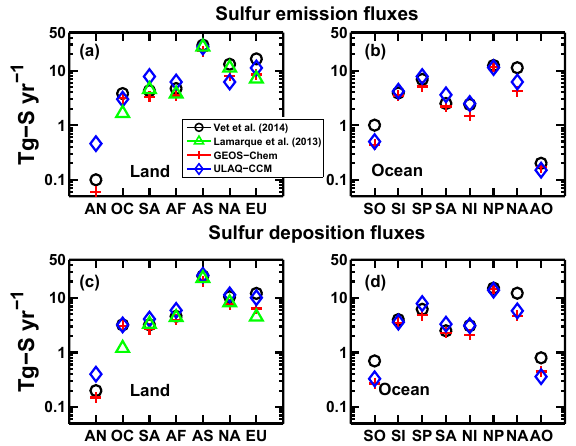
Figure 11. Regional area averaged emission and deposition fluxes of sulfur in (a) and (b) , on the one hand, and (c) and (d) , on the other, respectively. Values from ULAQ-CCM (blue) and GEOS- Chem (red) are averaged over the years 2000–2002 (i.e., historical reference experiment for ULAQ-CCM and Base case for GEOS- Chem). Observations and multi-model averages reported in Vet et al. (2014) and Lamarque et al. (2013) are shown for compar- ison (years 2001 and 2000, respectively). Land regions are pre- sented in (a) and (c) (Antarctica, Oceania, South America, Africa, Asia, North America, Europe); ocean regions are presented in (b)